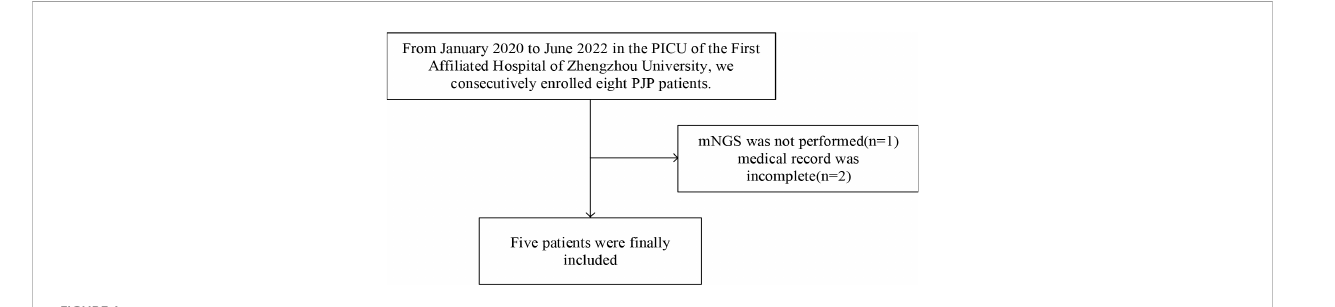
FIGURE 1 Flow diagram of the patients included in the